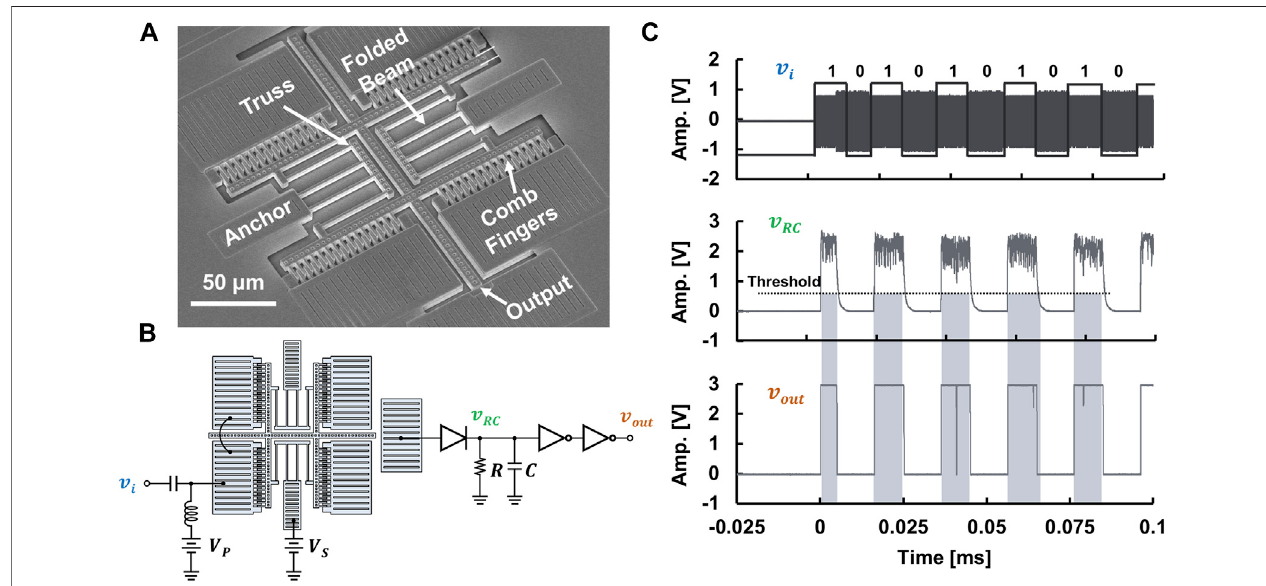
FIGURE 3 | Resoswitch-based zero-quiescent power receiver. (A) SEM of the comb-driven resoswitch of Tsai et al. (2020a). (B) Circuit schematic of the resoswitch-embedded receiver with simple backend circuits for demodulation. (C) Measured time-domain waveforms. Reproduced from Tsai et al. (2020a) with permission from IEEE.